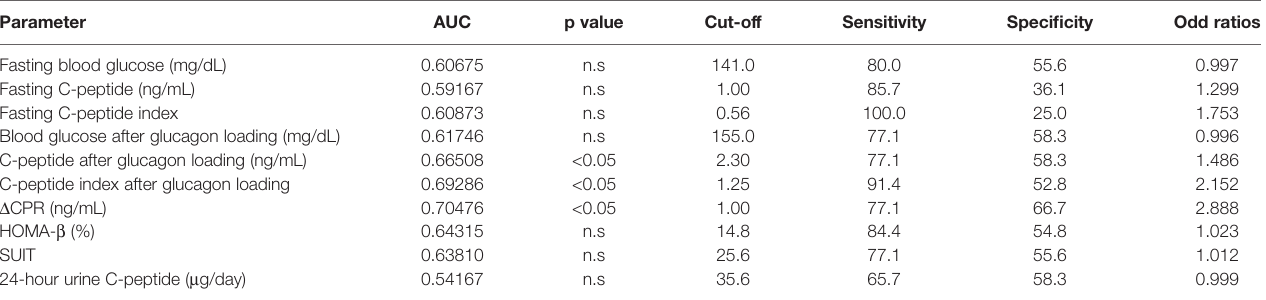
TABLE 3 | ROC curves to determine cutoff values of each indicator for withdrawal from insulin therapy. Parameter AUC Fasting blood glucose (mg/dL)